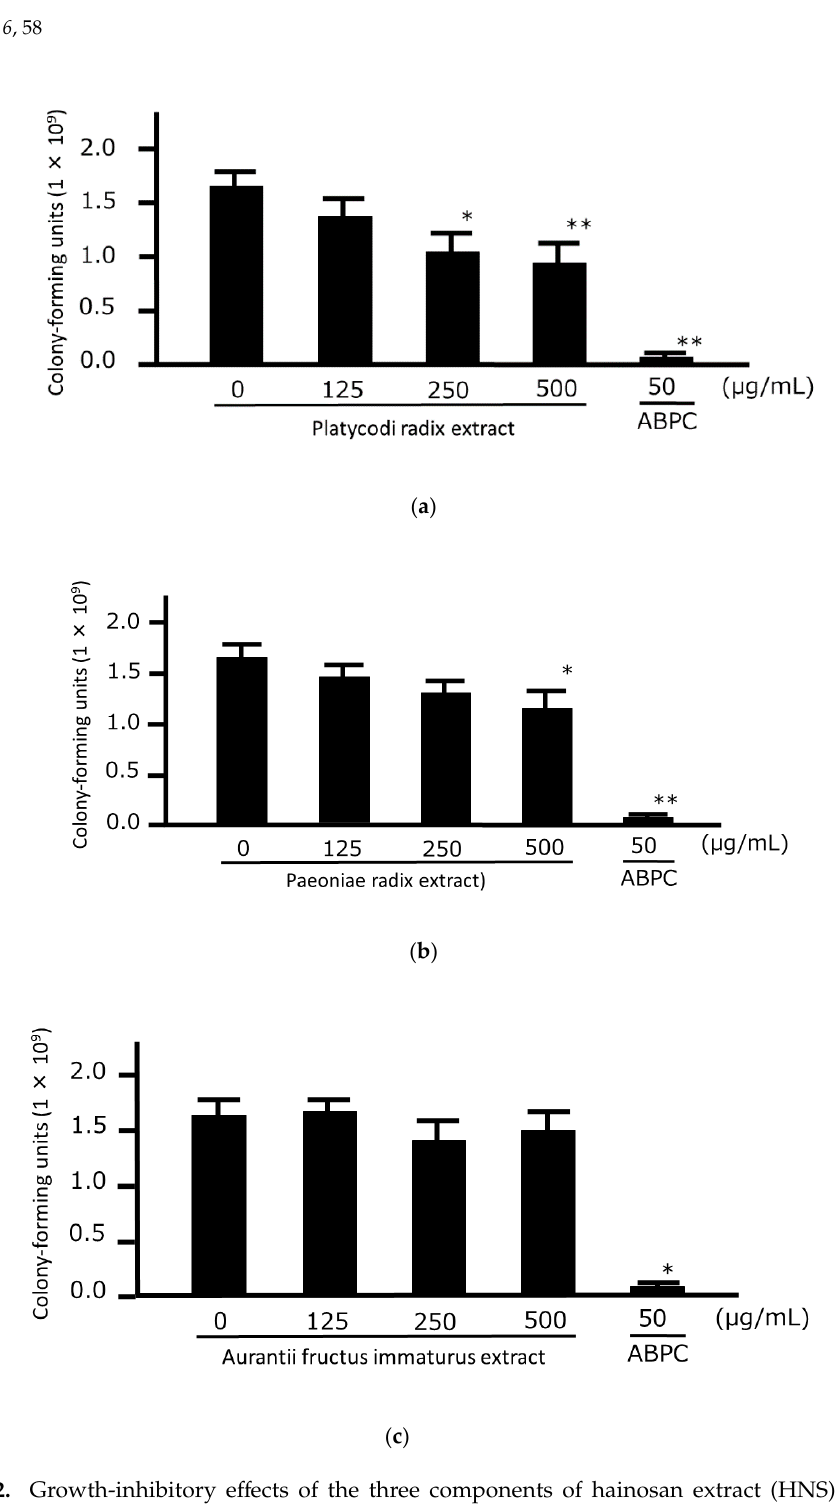
Figure 2. Growth-inhibitory effects of the three components of hainosan extract (HNS) against Porphyromonas gingivalis . P. gingivalis JCM12257 was treated with extracts of Platycodi Radix ( a ), Paeoniae Radix ( b ), or Aurantii Fructus Immaturus ( c ) for 48 h. An Aliquot of each liquid culture was then inoculated onto a CDC anaerobic plate and cultured for 2 d in an anaerobic atmosphere, following which the number of colony-forming units was counted. Data points represent the numbers of viable cells in a culture medium or culture medium containing HNS and represent means ± SD (n = 3). * p < 0.05, ** p < 0.01 vs. the untreated group (Tukey’s multiple comparison test).